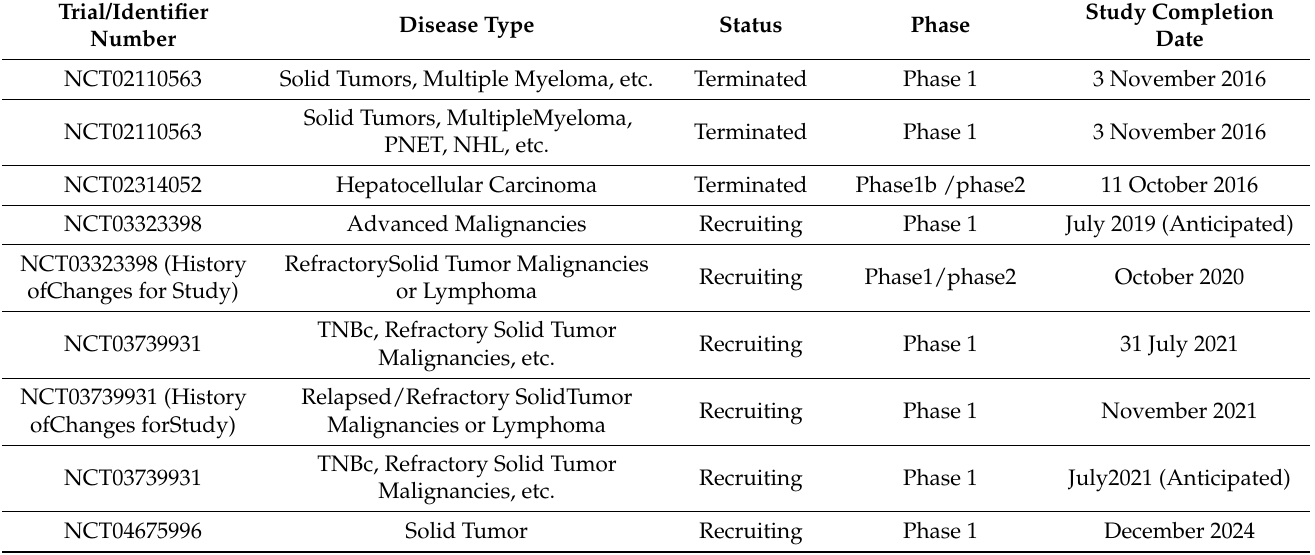
Table 3. List of SLNs under clinical trials.